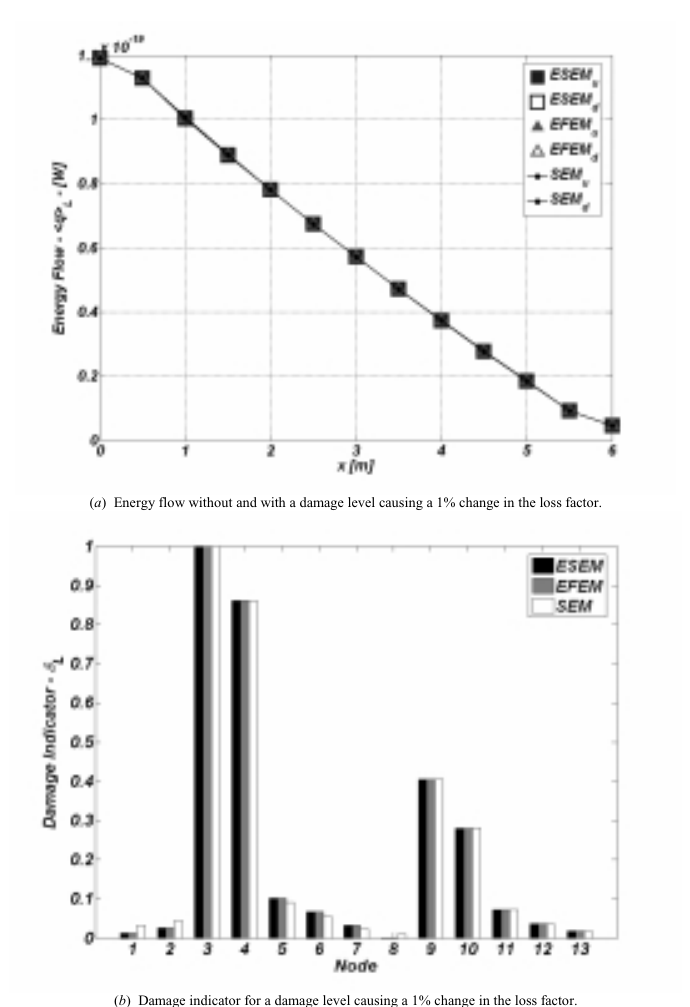
Fig. 2. Longitudinal energy flow and damage indicator by ESEM, SEM and